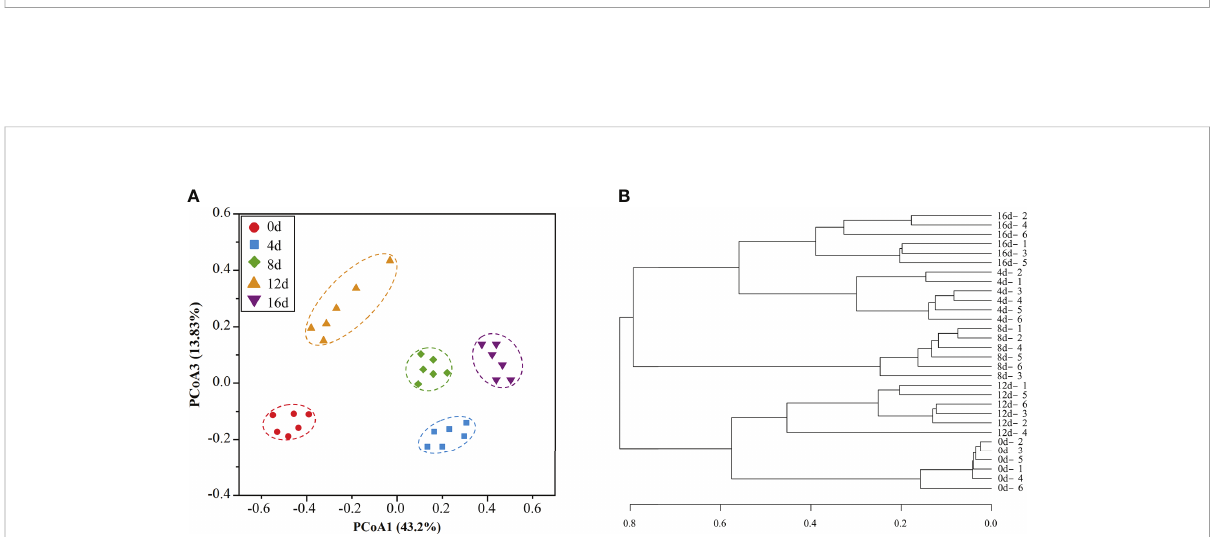
FIGURE 3 PCoA analysis (A) and Similarity tree (B) of intestinal microbial community of this hybrid